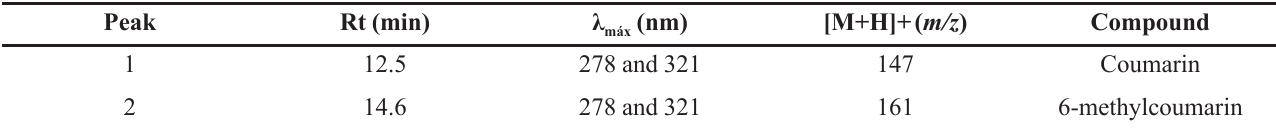
TABLE III - The main coumarinic compounds identified by LC-ESI/MS analysis in plasma after oral administration of